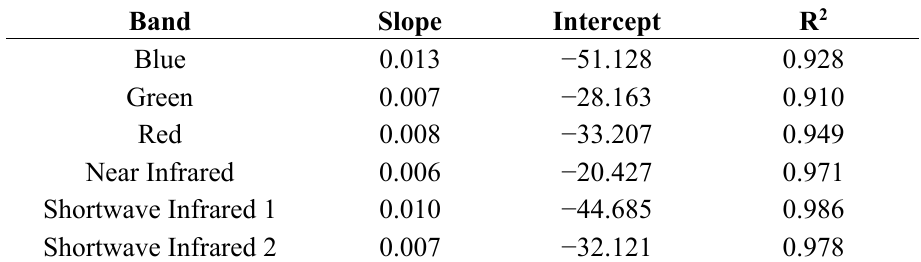
Table 1. Coefficients of linear regression models (one for each spectral band) developed using pseudo-invariant targets. These linear models were constructed in order to match